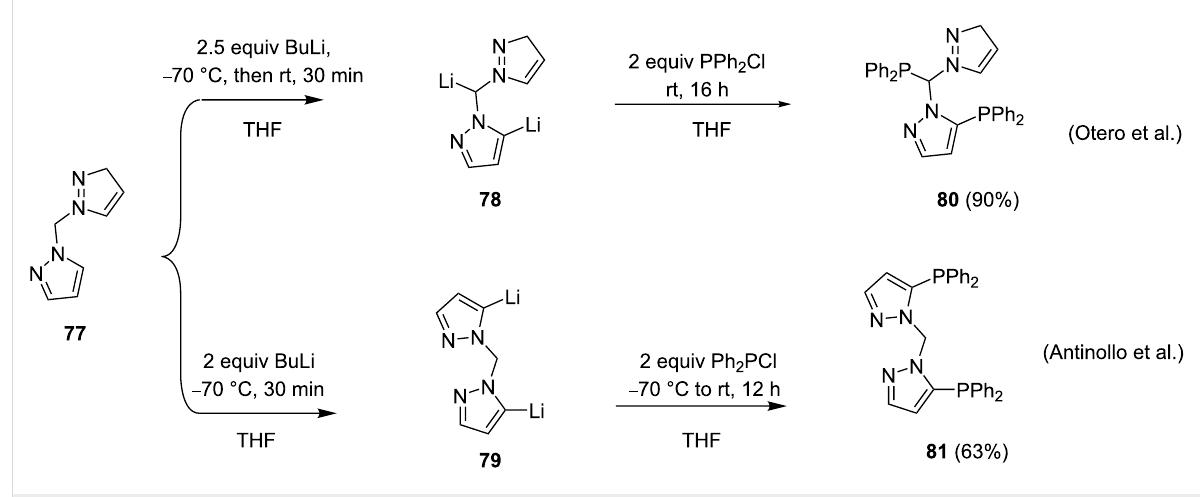
Scheme 15: Synthesis of isomeric phosphine dipyrazole ligands by varying the reaction